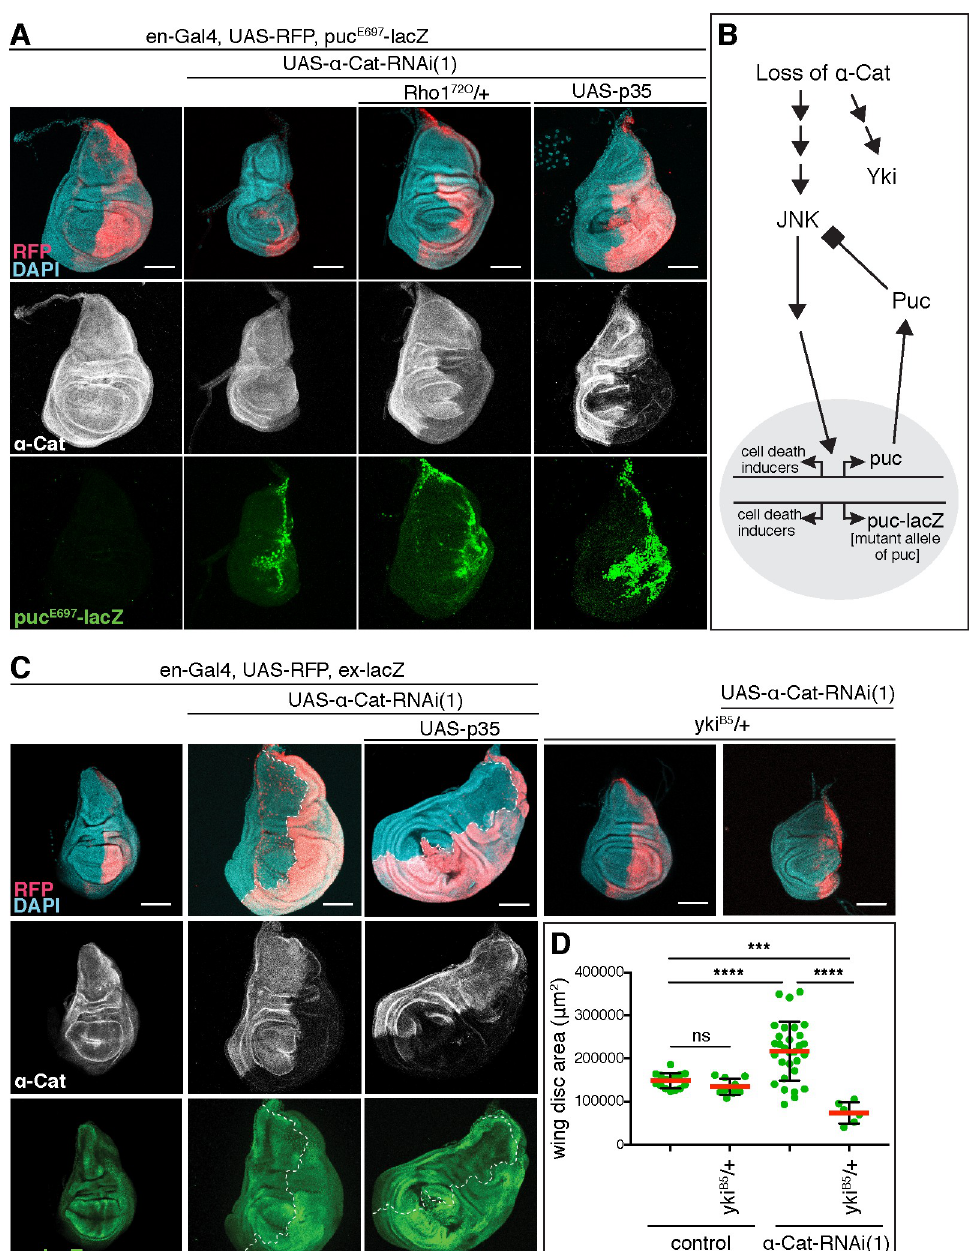
Fig 2. Loss of α -Cat activates JNK pathway and Yki. (A) Activation of the JNK transcriptional reporter puc-LacZ is seen when α -Cat is depleted in the PC. The strong reduction of the PC in α -Cat-RNAi(1) and puc-LacZ compared to α -Cat- RNAi(1) wing discs (see Fig 1C) indicates a genetic interaction between α -Cat-RNAi(1) and puc-LacZ . The loss of the PC can be rescued by expression of p35 or removal of one copy of Rho1. Scale bars, 100 μ m. (B) Schematic illustrating the relationship between Puc and JNK. The phosphatase Puc dephosphorylates and therefore deactivates the JNK kinase. The presence of the puc mutant allele puc-lacZ is predicted to hyper-activate JNK in conjunction with a KD of α -Cat, which causes enhanced cell death as observed in (A). (C) Elevated expression of the Yki transcriptional reporter ex-lacZ is observed upon KD of α -Cat in the absence or presence of p35. Tissue overgrowth is suppressed through the addition of a null mutant copy of yki ( yki B5 ). Scale bars, 100 μ m. (D) Quantification of wing disc area in flies of indicated genotypes. Two-tailed, unpaired t-test; ns (P > 0.05), ���� (P � 0.0001), ��� (P = 0.0003).